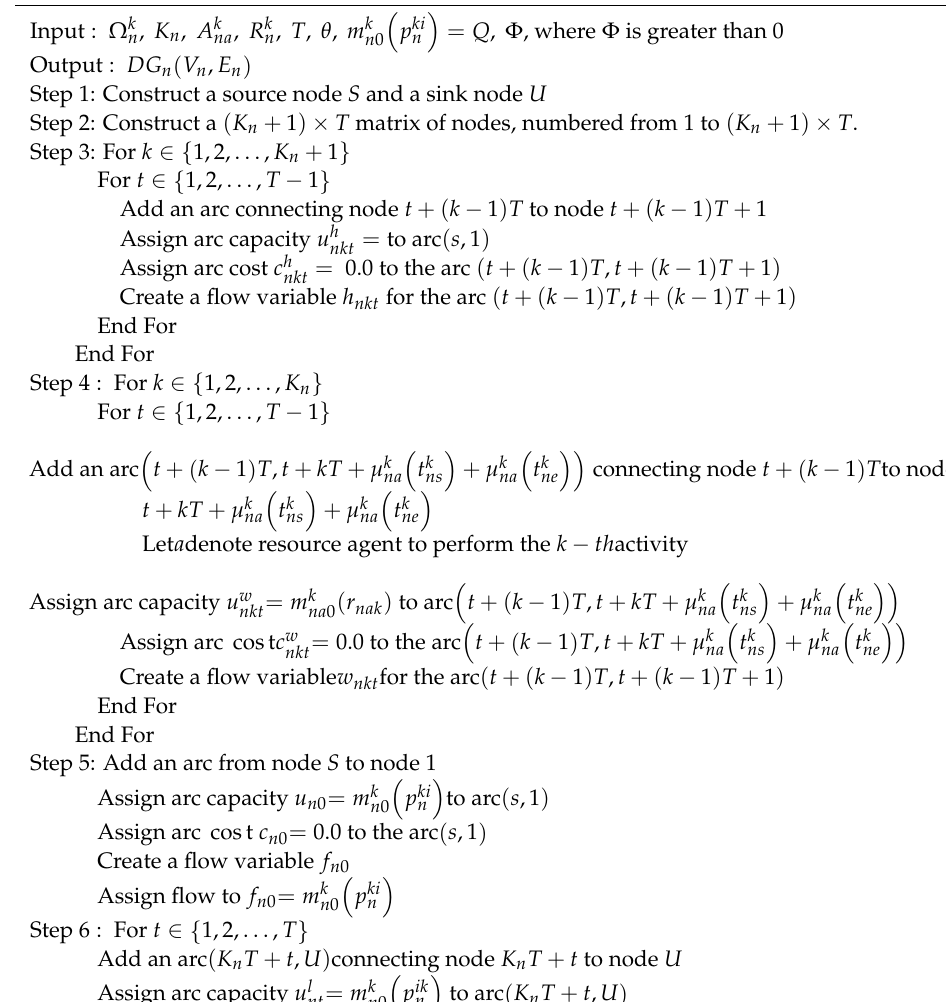
Algorithms 1 DTPN to Graph Transformation (DTPN2GT)